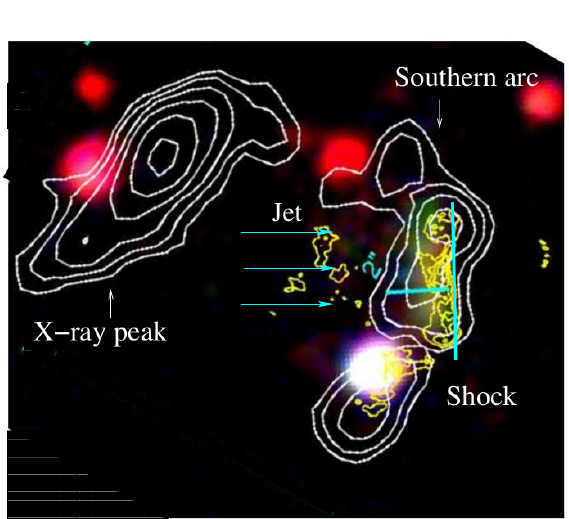
Figure 6. Hotspot at the southern jet of the FRII galaxy 4C74.26. White and yellow contours are X-rays and (MERLIN) radio data, respectively. Red and green correspond to IR and optical, respec- tively. One arcsecond represents 1.887 kpc on the plane of the sky at the location of the source ( z = 0 . 104). Adapted from